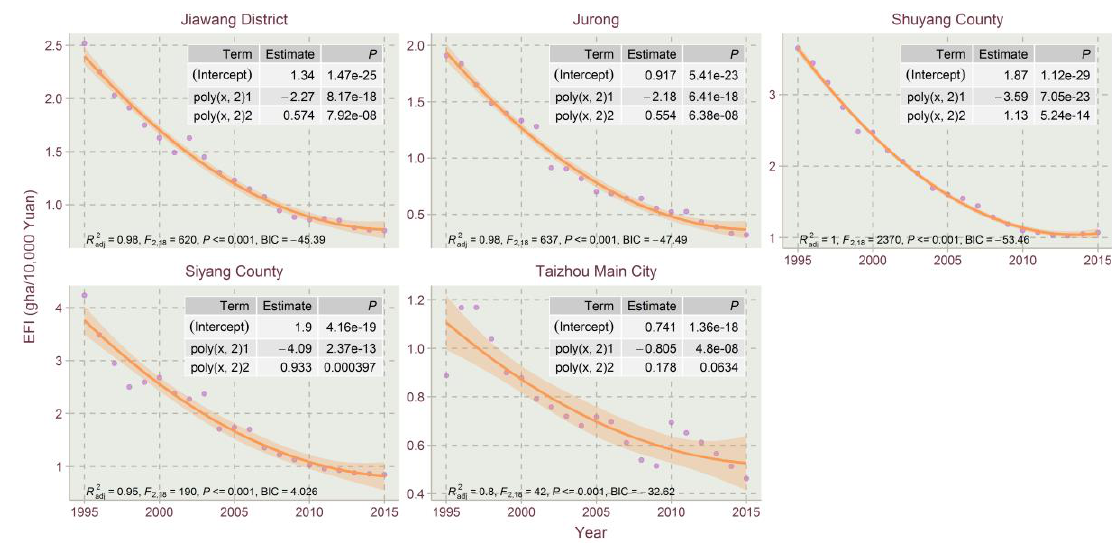
Figure 6. Quadratic orthogonal curve fitting of EFIs of Jiangsu Province for 1995–2015 (Part 2).